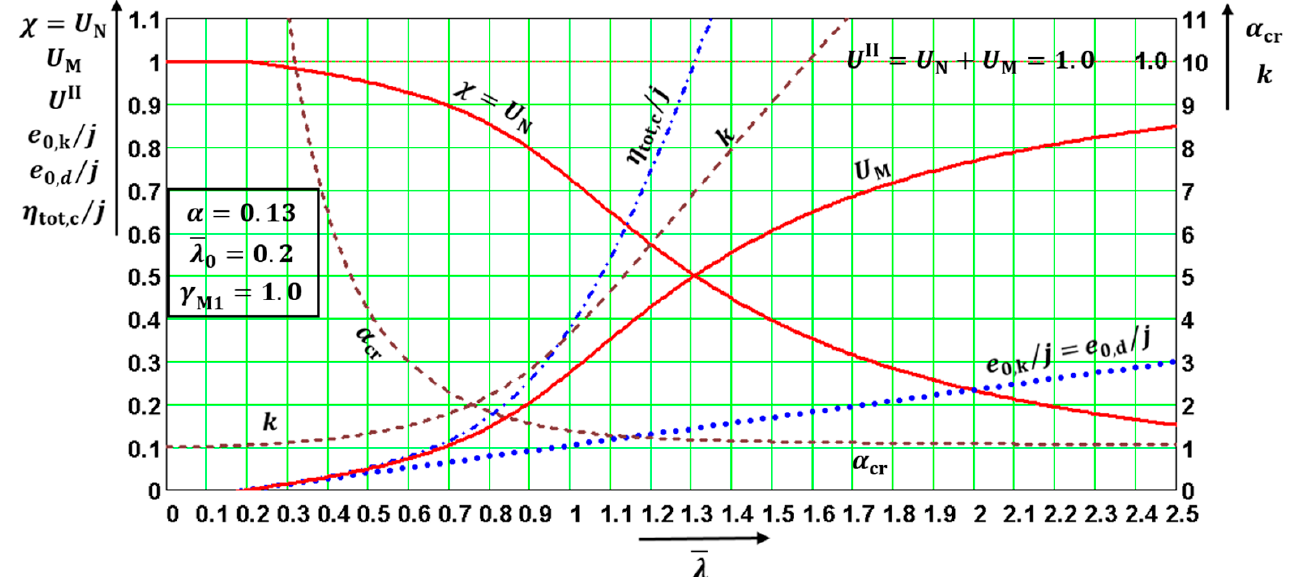
⁄ . Only quanti- Figure 3. Relevant quantities for α = 0.13, γ M1 = 1.0, and N Ed = N b,Rd = χ Af y / γ M1 . Only = 𝑁 = 𝜒𝐴𝑓 𝛾 (cid:2889)(cid:2914) (cid:2912),(cid:2902)(cid:2914) (cid:2935) (cid:2897)(cid:2869)